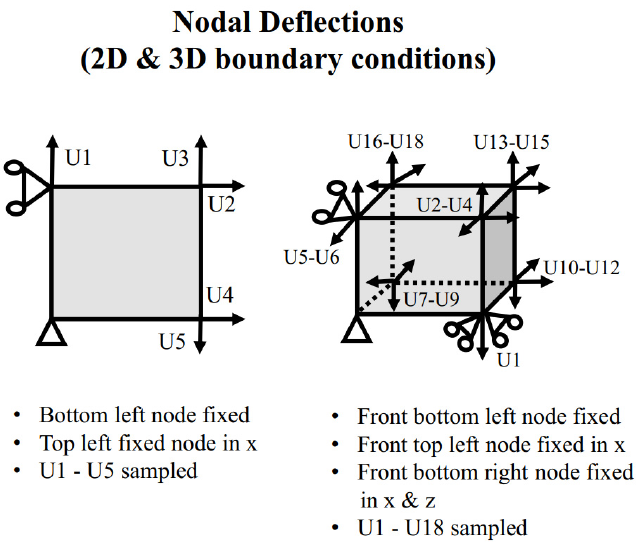
Figure 4. Description of nodal deflection of 2D and 3D objects [19].